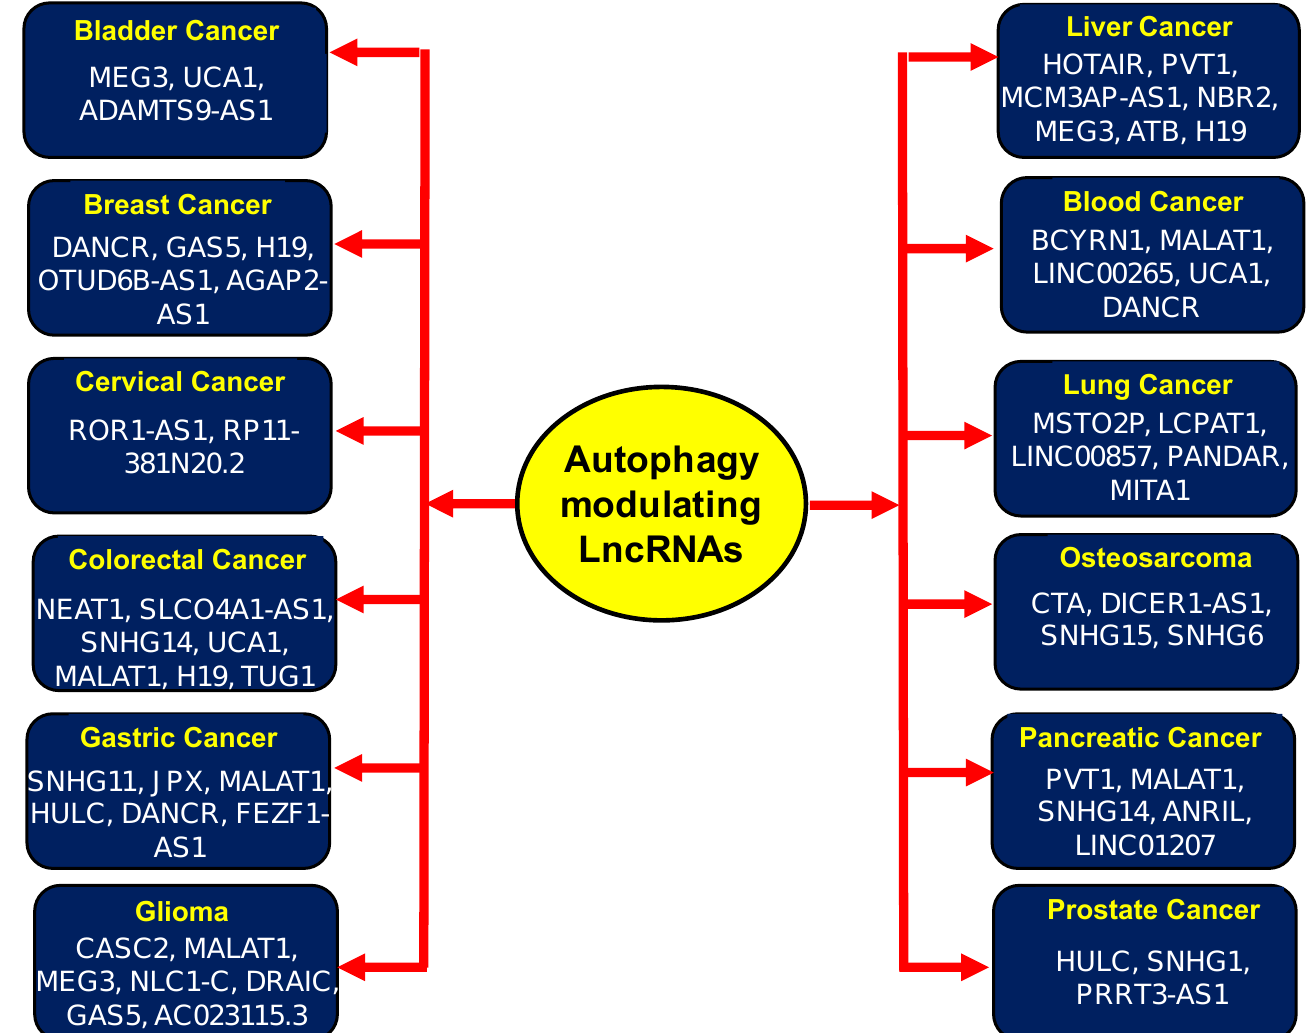
Figure 2. Autophagy-modulating lncRNAs targeting various types of cancers.